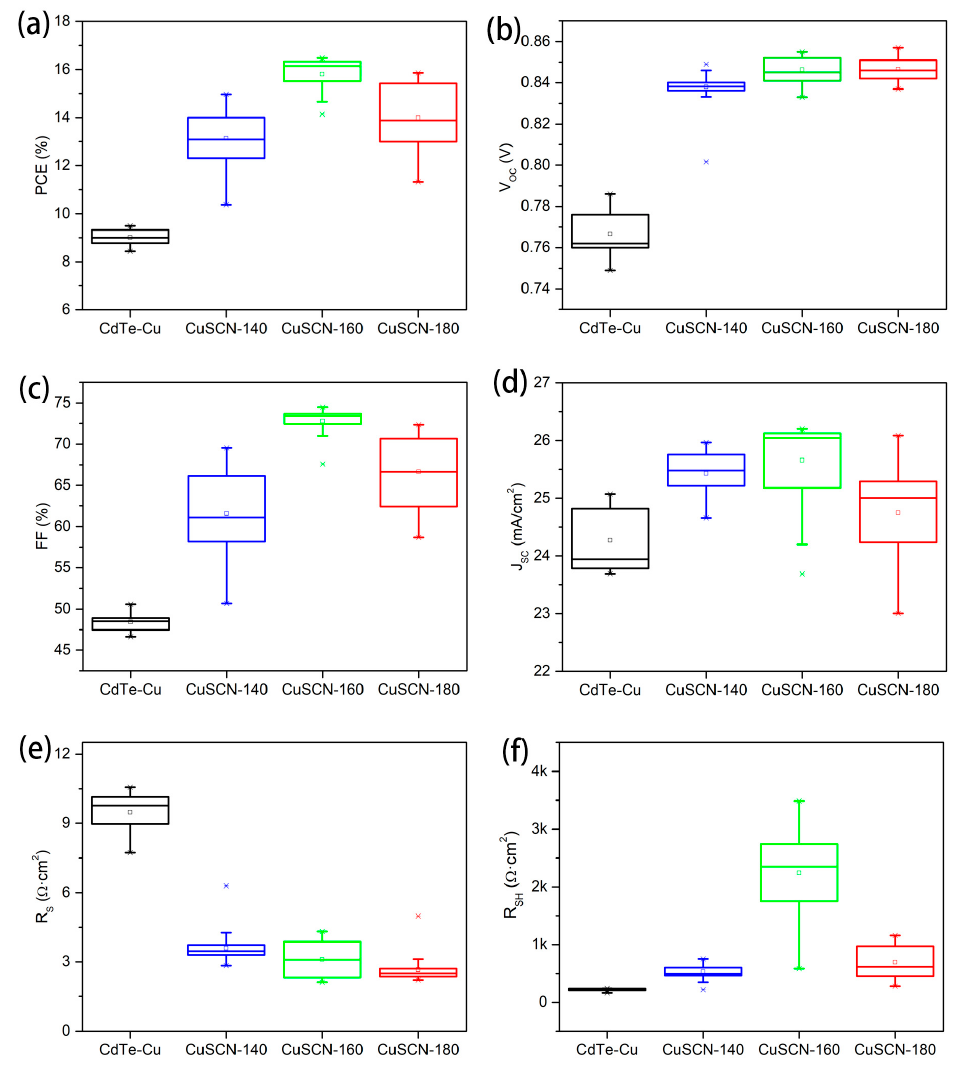
Figure 2. Statistical results for MZO / CdTe solar cell performances of ( a ) PCE, ( b ) V OC , ( c ) FF, ( d ) J SC , ( e ) series resistance (R S ), and ( f ) shunt resistance (R SH ) with metallic Cu and spin-coated CuSCN annealed at different temperatures.